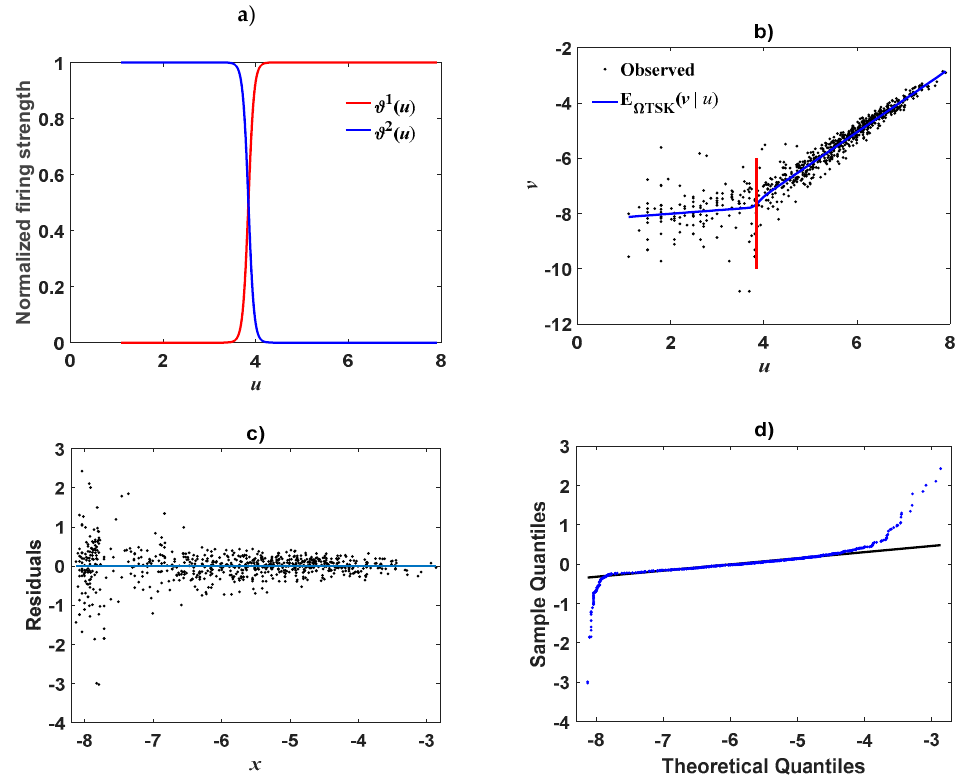
Figure 10. Fit of the Ω TSK ( u ) proxy on the eelgrass data. Panel ( a ) shows firing strengths ϑ 1 ( u ) and Figure 10. Fit of the 𝛺 (cid:3021)(cid:3020)(cid:3012) (𝑢) proxy on the eelgrass data. Panel ( a ) shows firing strengths 𝜗 (cid:2869) (𝑢) and ϑ 2 ( u ) for the biphasic characterization of Ω ( u ) . Panel ( b ) exhibits dispersion of v about fitted TSK 𝜗 (cid:2870) (𝑢) for the biphasic characterization of 𝛺 (cid:3021)(cid:3020)(cid:3012) (𝑢) . Panel ( b ) exhibits dispersion of 𝑣 about fitted TSK mean response E Ω TSK ( v | u ) vertical segment signposts estimated break point. Panel ( c ) shows residual TSK mean response 𝐸 (cid:3078)(cid:3021)(cid:3020)(cid:3012) (𝑣|𝑢) vertical segment signposts estimated break point. Panel ( c ) shows dispersion about the zero line. Panel ( d ) displays normal QQ residual dispersion about the zero line. Panel ( d ) displays normal QQ plot.